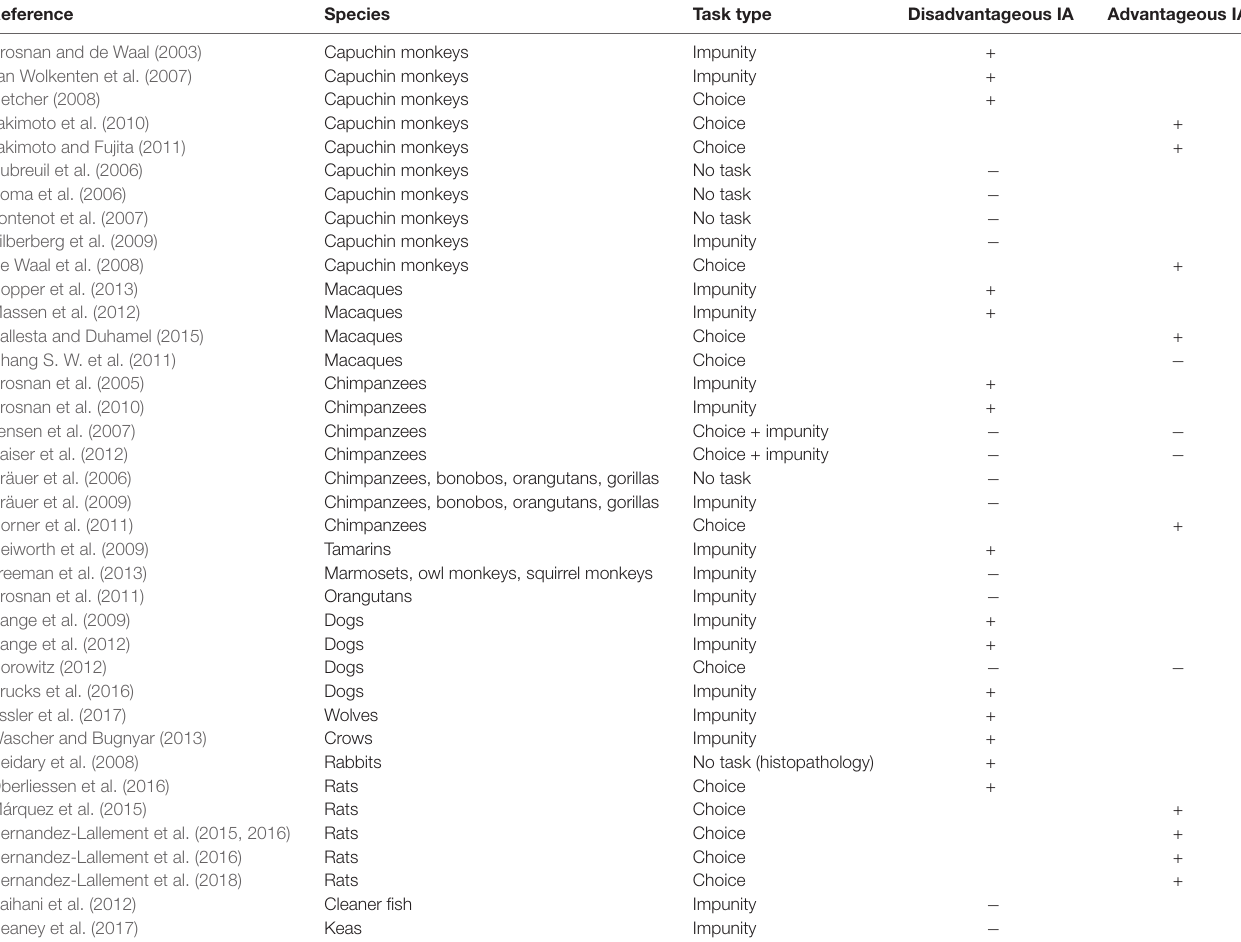
TABLE 1 | Evidence for and against inequity aversion in non-human animal species using different task